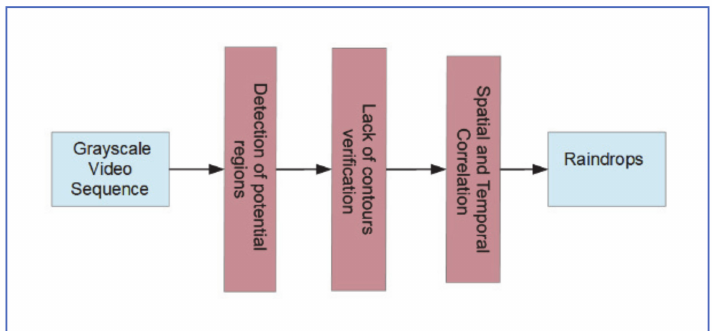
Figure 19. Detection algorithm described in